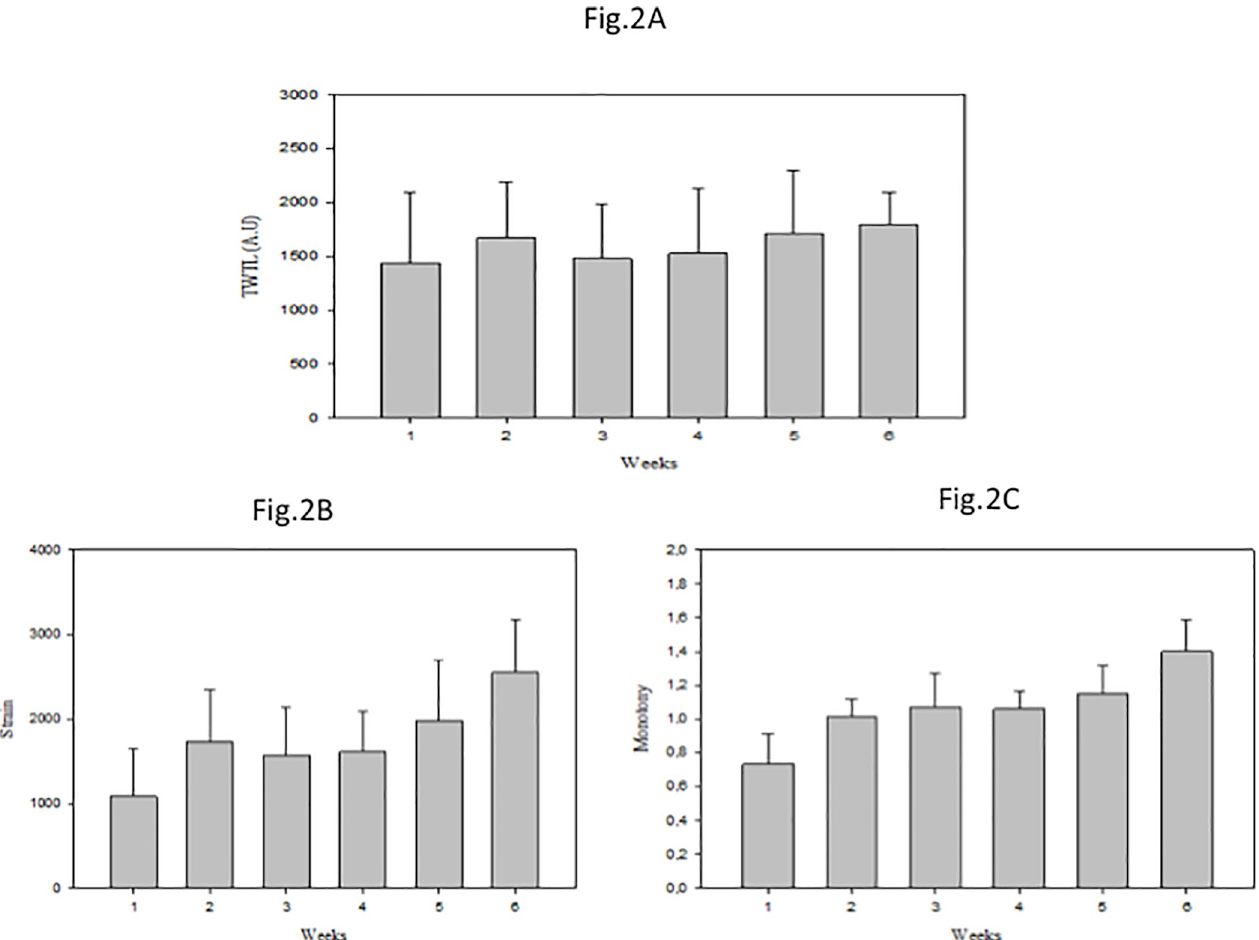
Fig 2. Total weekly training load (TWTL) (Fig 2A), the monotony (Fig 2B) and the strain (Fig 2C) of the six weeks training during the match congestion period. �� = Significant differences compared to week 1, week 3, and week 4 (p � 0.01). TWTL = Total weekly training load; A.U. = arbitrary units, monotony and strain.